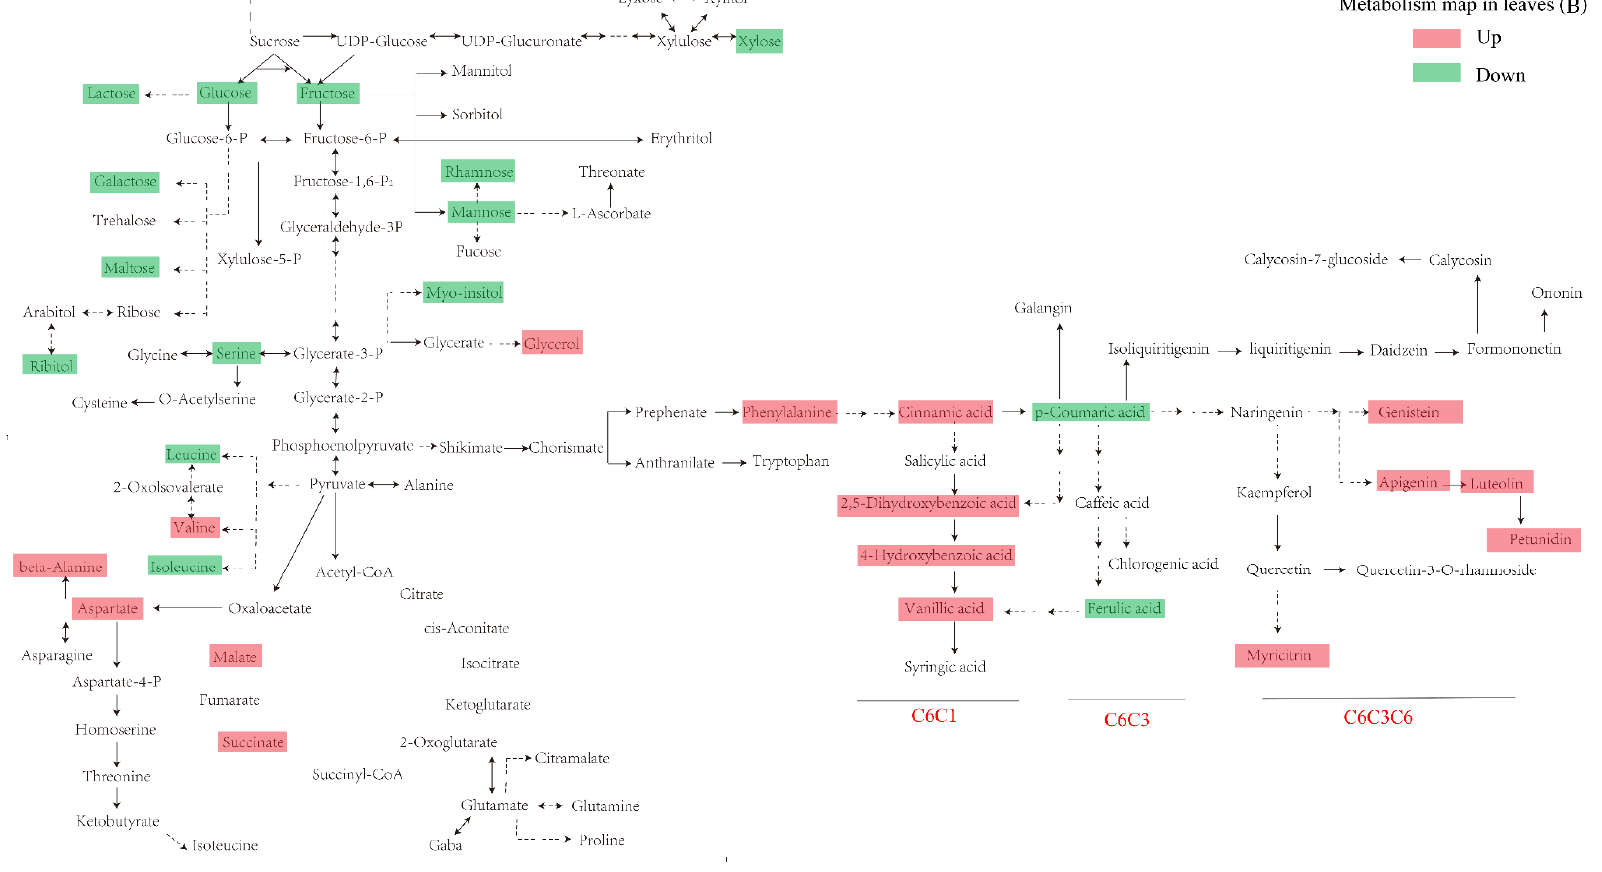
Figure 5. Visualization of primary and phenolic metabolites dynamics on a biochemical pathway map. ( A ) Metabolism map in roots. ( B ) Metabolism map in leaves. Compounds in the red box are upregulated by UV-B radiation, and compounds in the green box are downregulated.